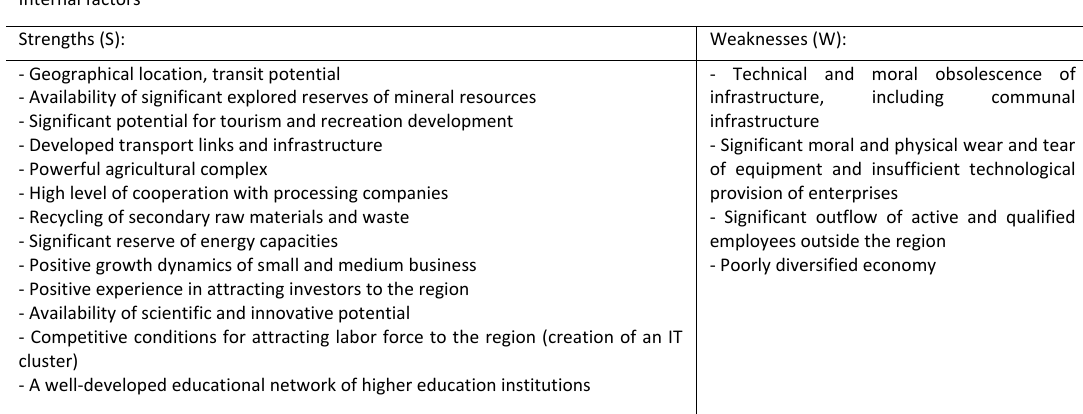
Table 1: Analysis of internal (strengths and weaknesses) and external (opportunities and threats) factors in rural areas of the Vinnytsia region